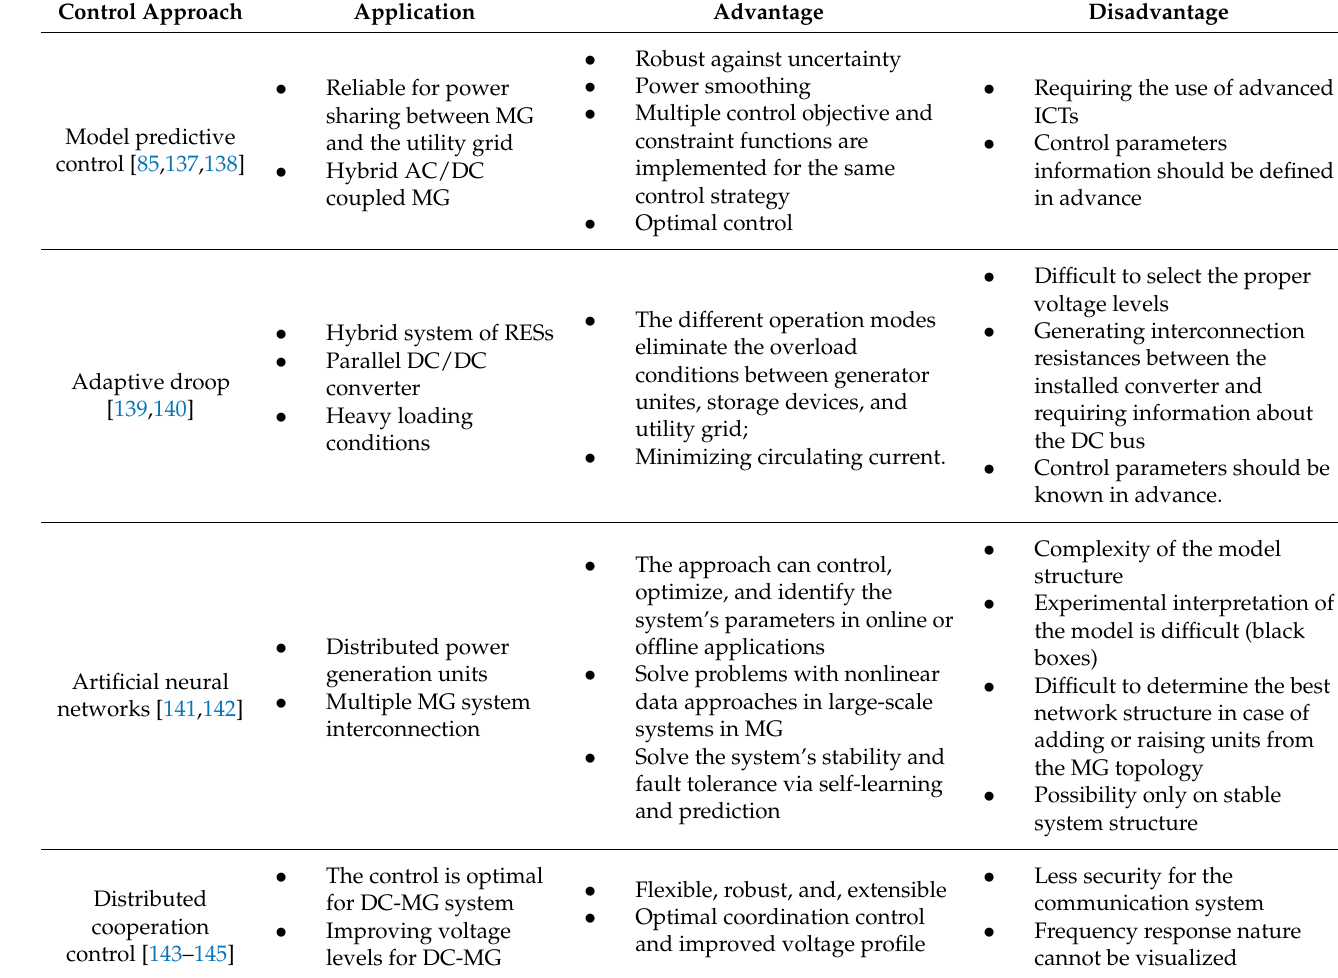
Table 4. Brief comparison of control